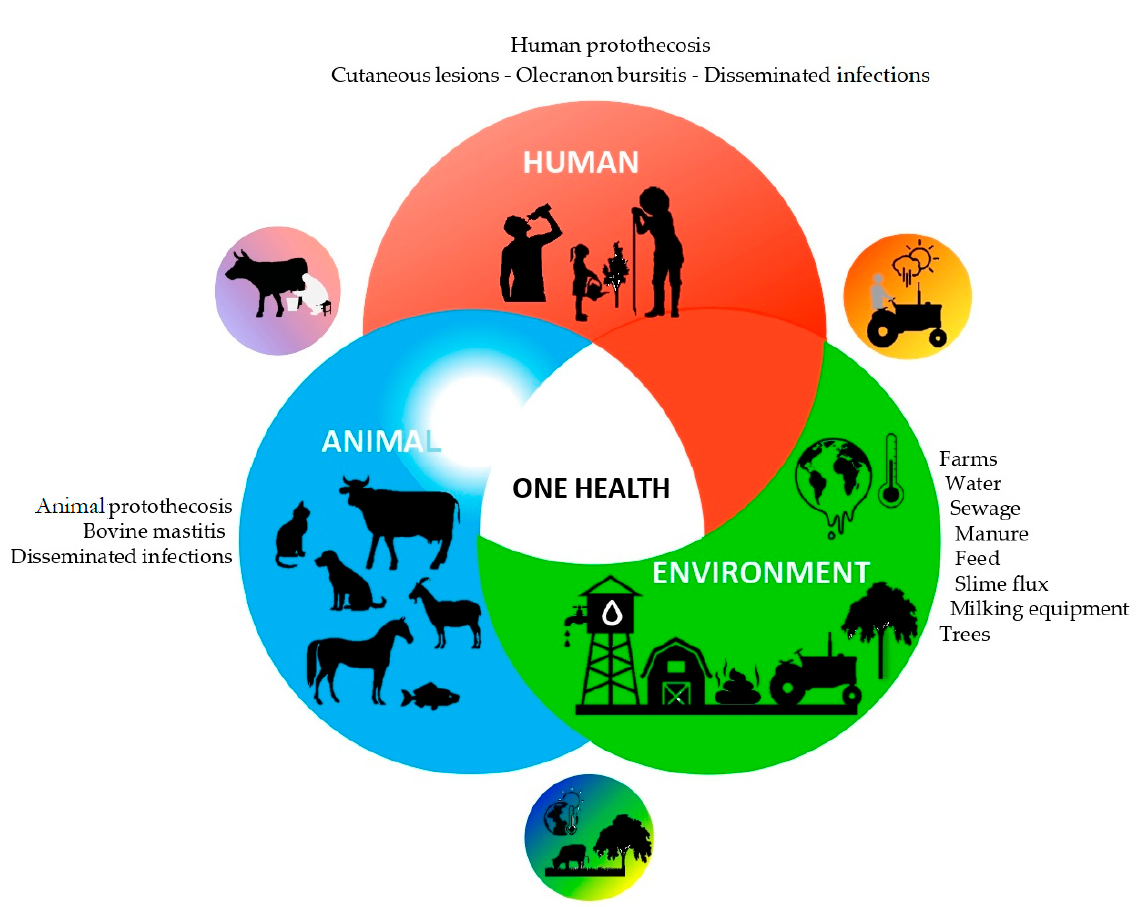
Figure 3. Prototheca infections and ecology from a One Health perspective: a schematic diagram summarizing the diverse habitats, human and animal hosts and possible routes of transmission for Prototheca microalgae.